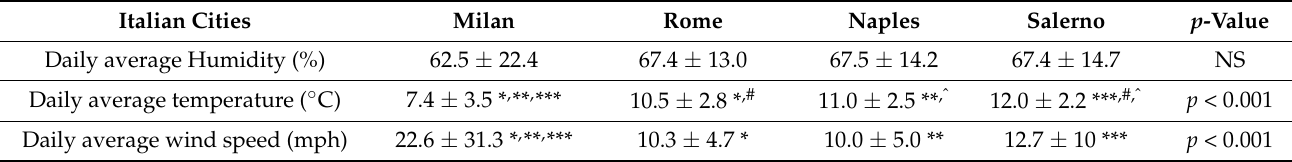
Table 3. Comparison of meteorological conditions among Milan, Rome, Naples, and Salerno (1 January 2020–8 April 2020). Italian Cities Milan Rome Naples Salerno p -Value Daily average Humidity (%) 62.5 ± 22.4 67.4 ± 13.0 67.5 ± 14.2 67.4 ± 14.7 NS Daily average temperature ( ◦ C) 7.4 ± 3.5 * , ** , *** p < 0.001 Daily average wind speed (mph) p <